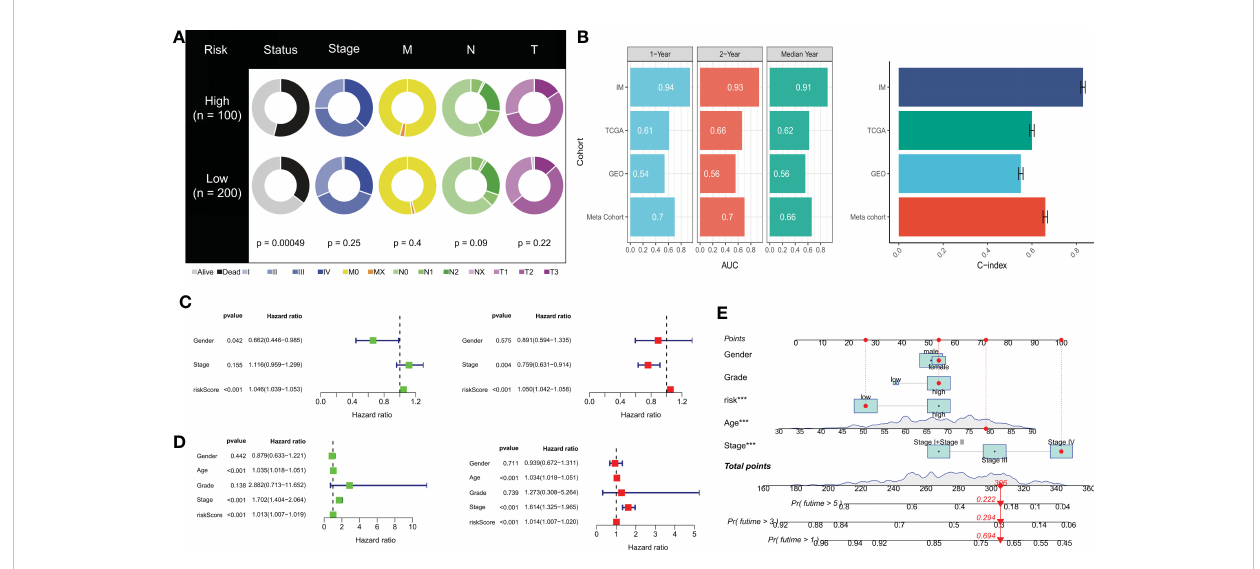
FIGURE 6 Prognostic value of risk scores and clinical characteristics of BLCA patients. (A) Pie chart showing the survival status and clinical stage of patients in high and low-risk groups. (B) AUC values for 1-year, 2-year, and median survival time in TCGA-BLCA, iMvigor210, GSE13507, and meta cohorts. Concordance index (C-index) for TCGA-BLCA, iMvigor210, GSE13507, and meta cohorts. (C) Univariate and (D) multivariate Cox analysis evaluating prognostic and clinical features, including age, grade, and stage. (E) Nomogram of risk score and clinical characteristics for predicting 1-, 3-, and 5- year survival rates in the TCGA cohort. ***P< 0.001.